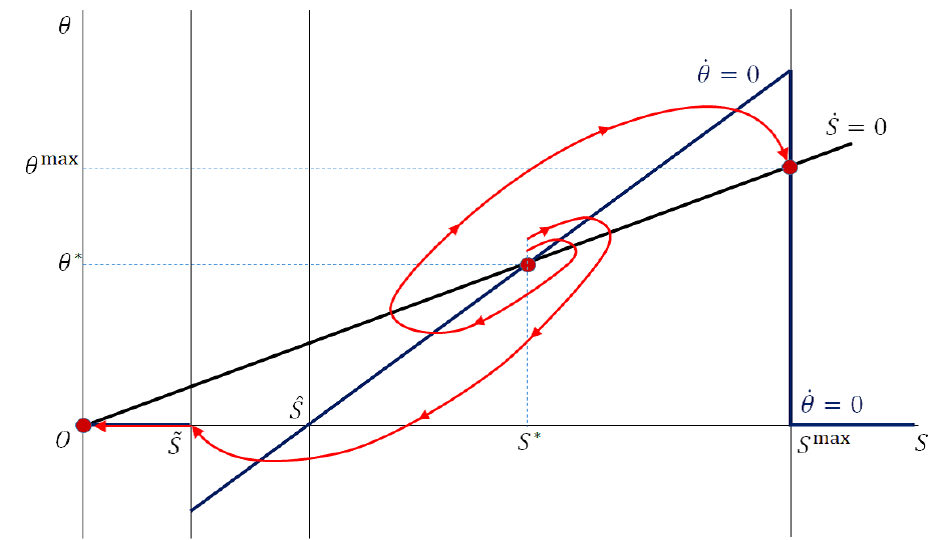
Figure 6. Indeterminacy of equilibrium